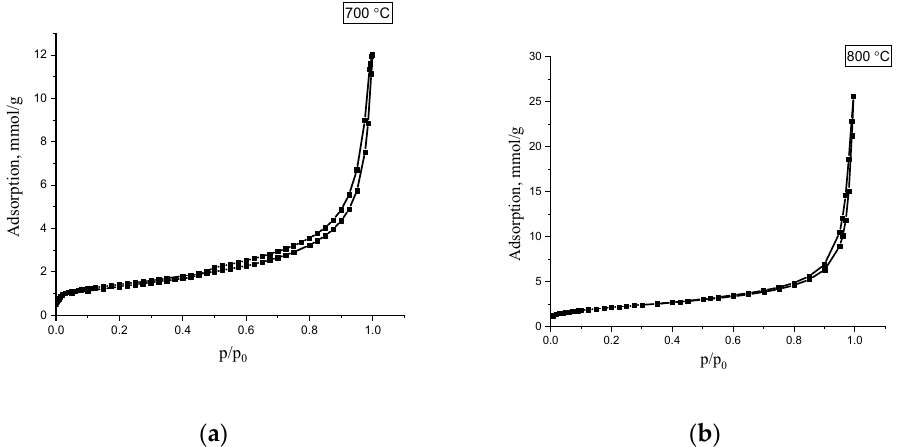
Figure 8. Low-temperature nitrogen adsorption isotherms for N-CNT, synthesized at the tempera- ture of 700 ° С ( a ) and 800 ° С ( b ). of 700 ◦ C ( a ) and 800 ◦ C ( b